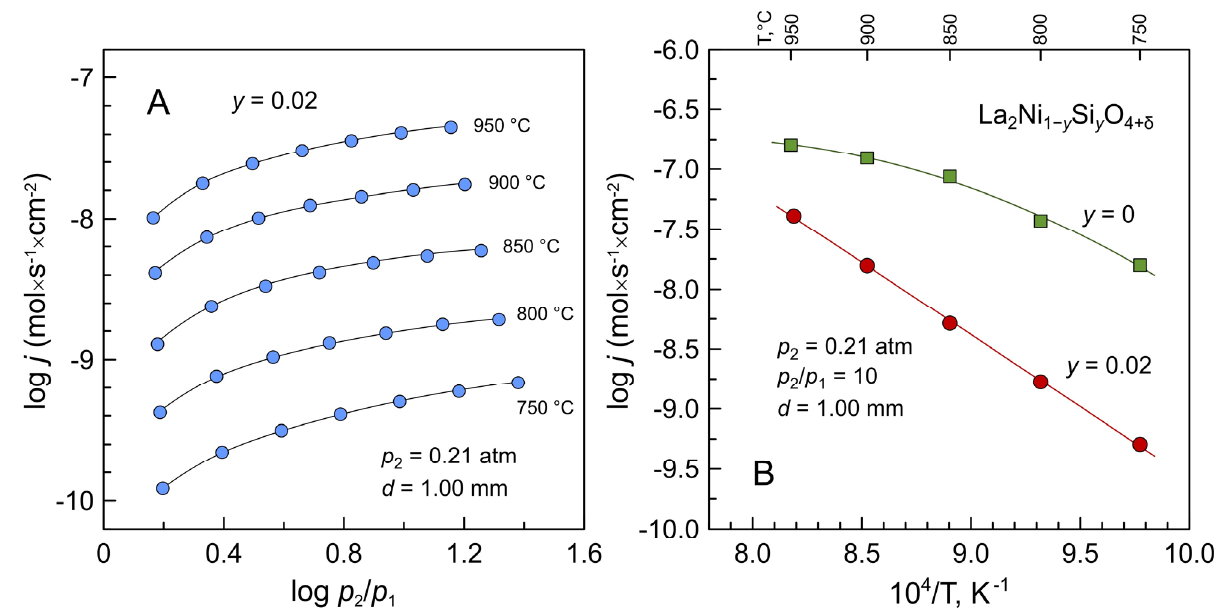
Figure 7. ( A ) Dependence of oxygen permeation fluxes through La 2 Ni 0.98 Si 0.02 O 4+ δ ceramic membrane on oxygen partial pressure gradient at 750–950 °C; ( B ) comparison of oxygen permeation fluxes through La 2 Ni 1 − y Si y O 4+ δ membranes under fixed p(O 2 ) gradient.